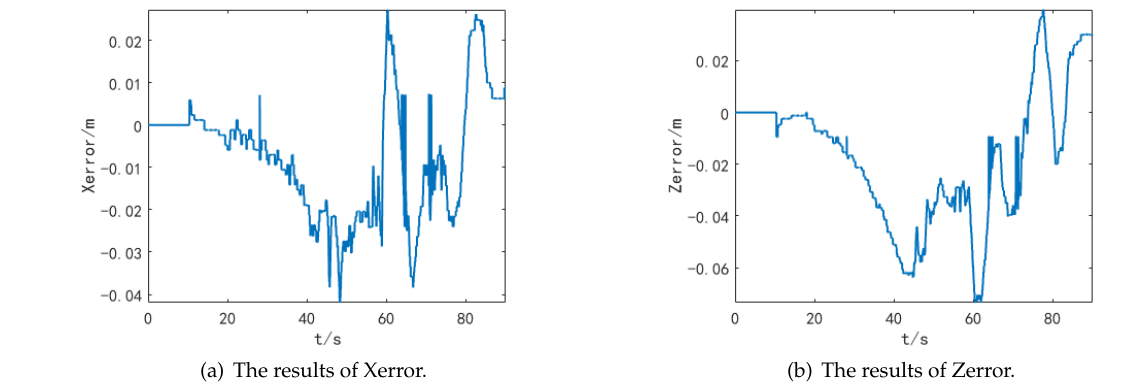
Figure 11. The result of Figure 10. The result of error.